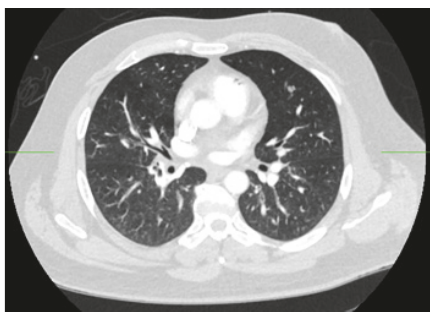
Figure 3: Gas in the main pulmonary artery and right lower lobe segmental pulmonary